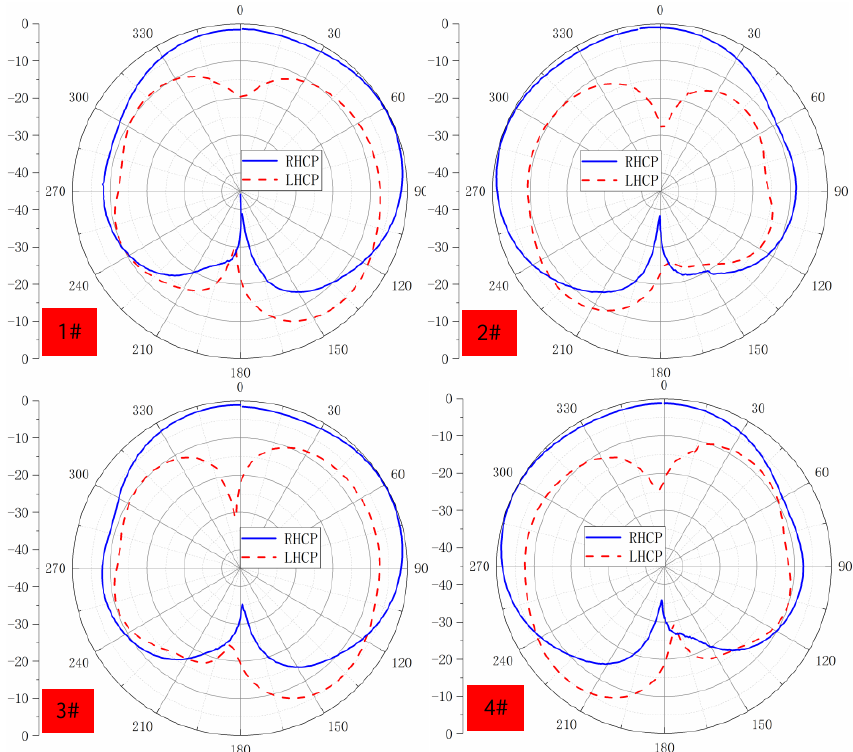
Figure 8. The measured normalized radiation patterns of each BDS antenna in the isolation enhanced